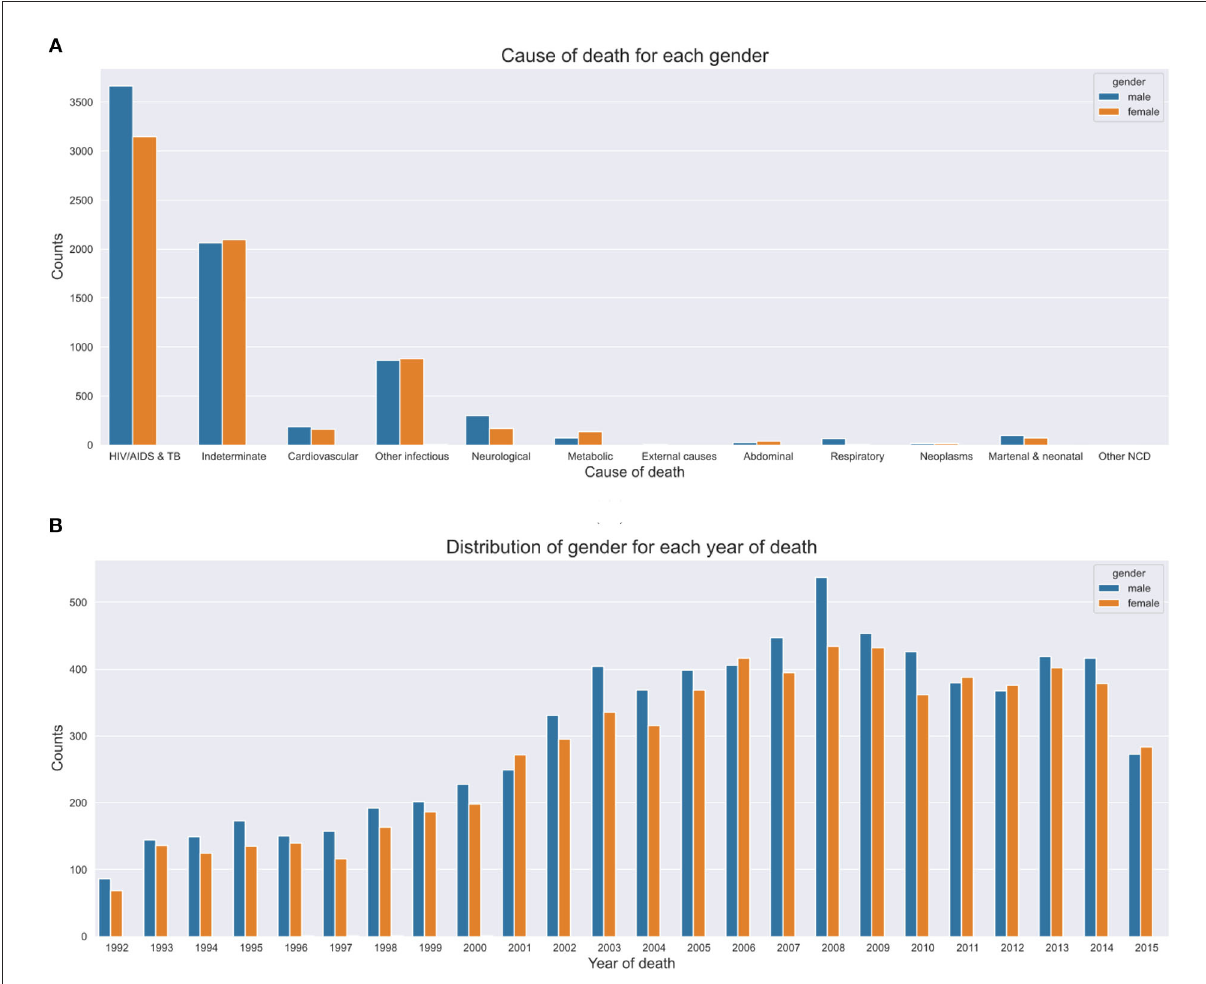
FIGURE7 Yearly CoD based on gender. (A) CoD based on gender. (B) Yearly CoD based on